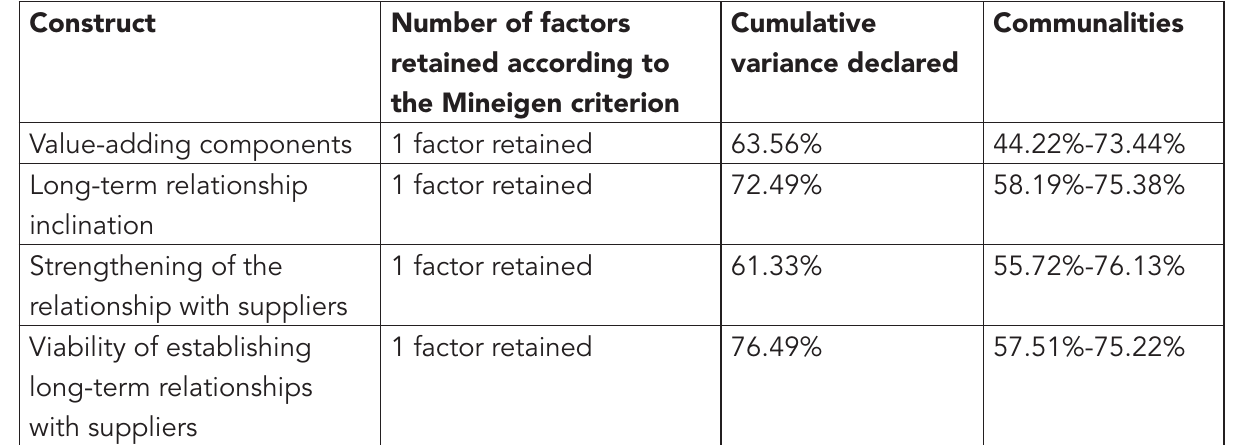
Table I: Results of the exploratory factor analysis